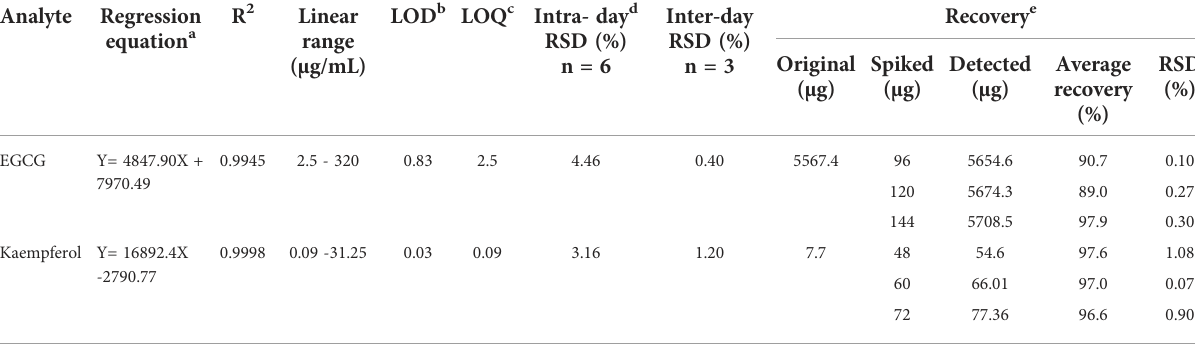
TABLE 1 Regression equation, linear range, LOD, LOQ, intra-day, inter-day and recovery studies for the target analytes.